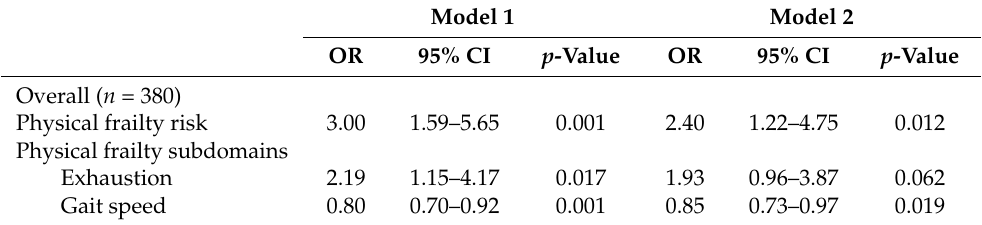
Table 3. Relationship between physical and oral